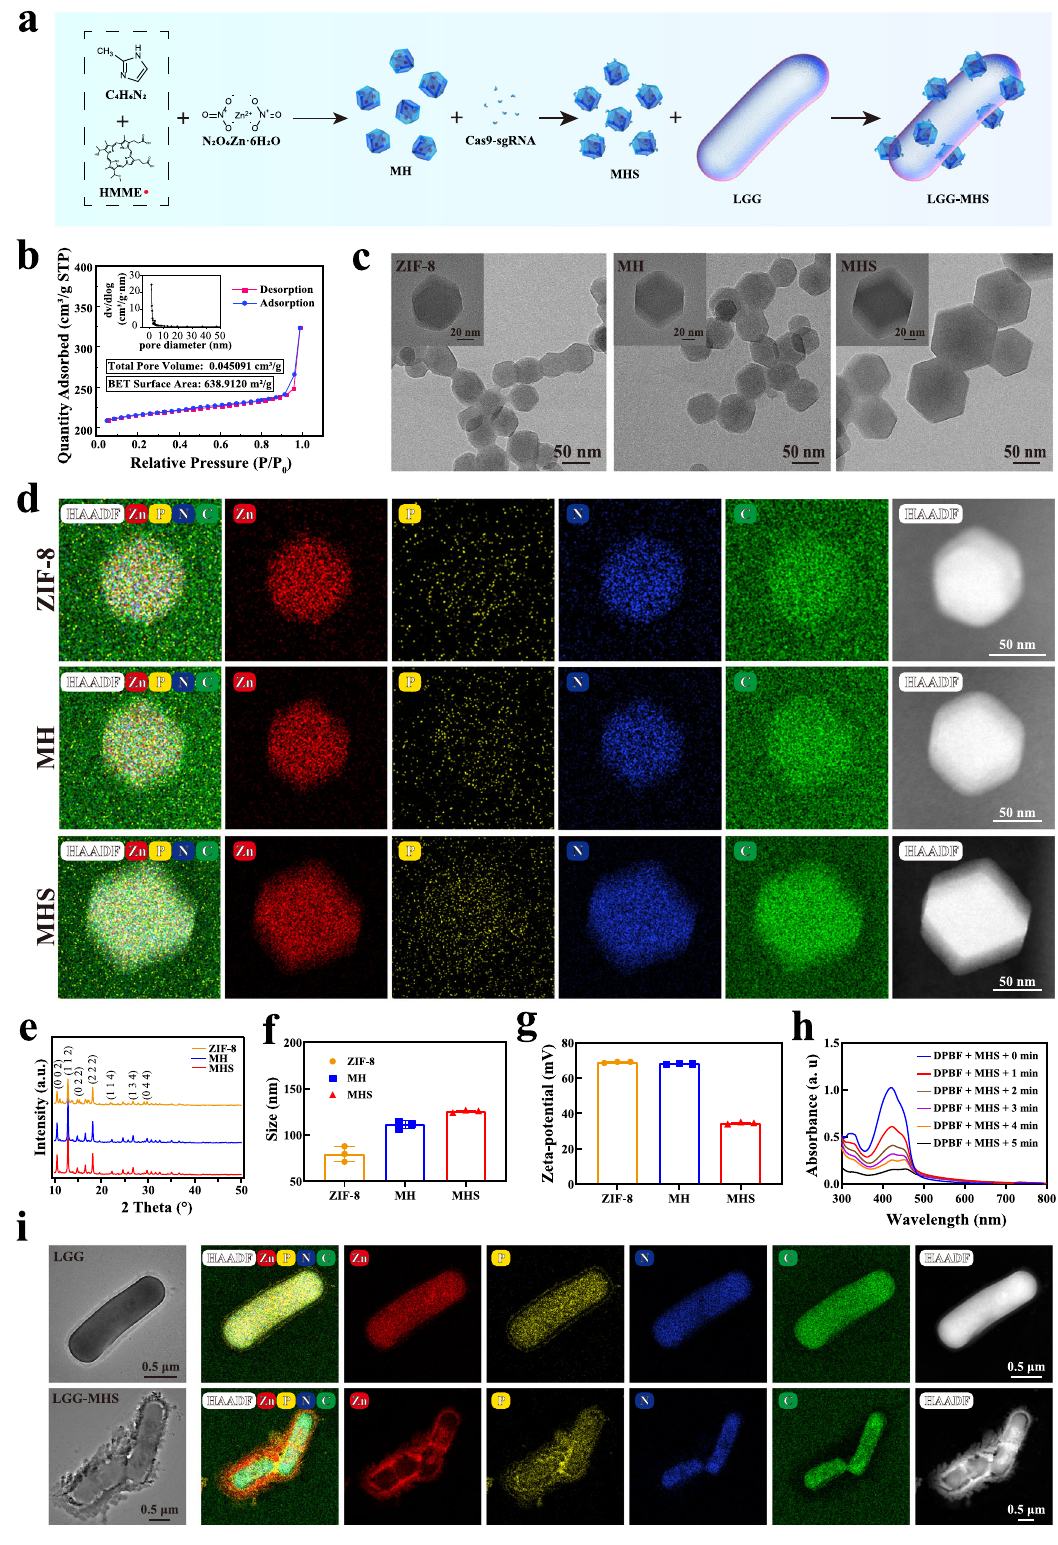
Fig. 2 | Synthesis and structural characterization of ZIF-8, MH, MHS, LGG, and LGG-MHS. a Synthesis procedure of LGG-MHS. b N 2 adsorption-desorption iso- therms and of MHS. The inset shows its corresponding total pore volume and speci fi csurfacearea. c Transmissionelectronmicroscopic(TEM)and d elemental mappings of ZIF-8, MH and MHS. e PXRD of ZIF-8, MH and MHS. f Particle size and g Zeta- potential of ZIF-8, MH, and MHS ( n =3 independent samples, data